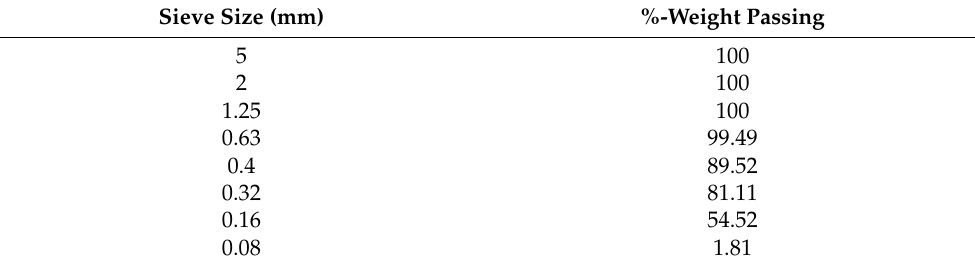
Table 2. Properties of tested sand sample.